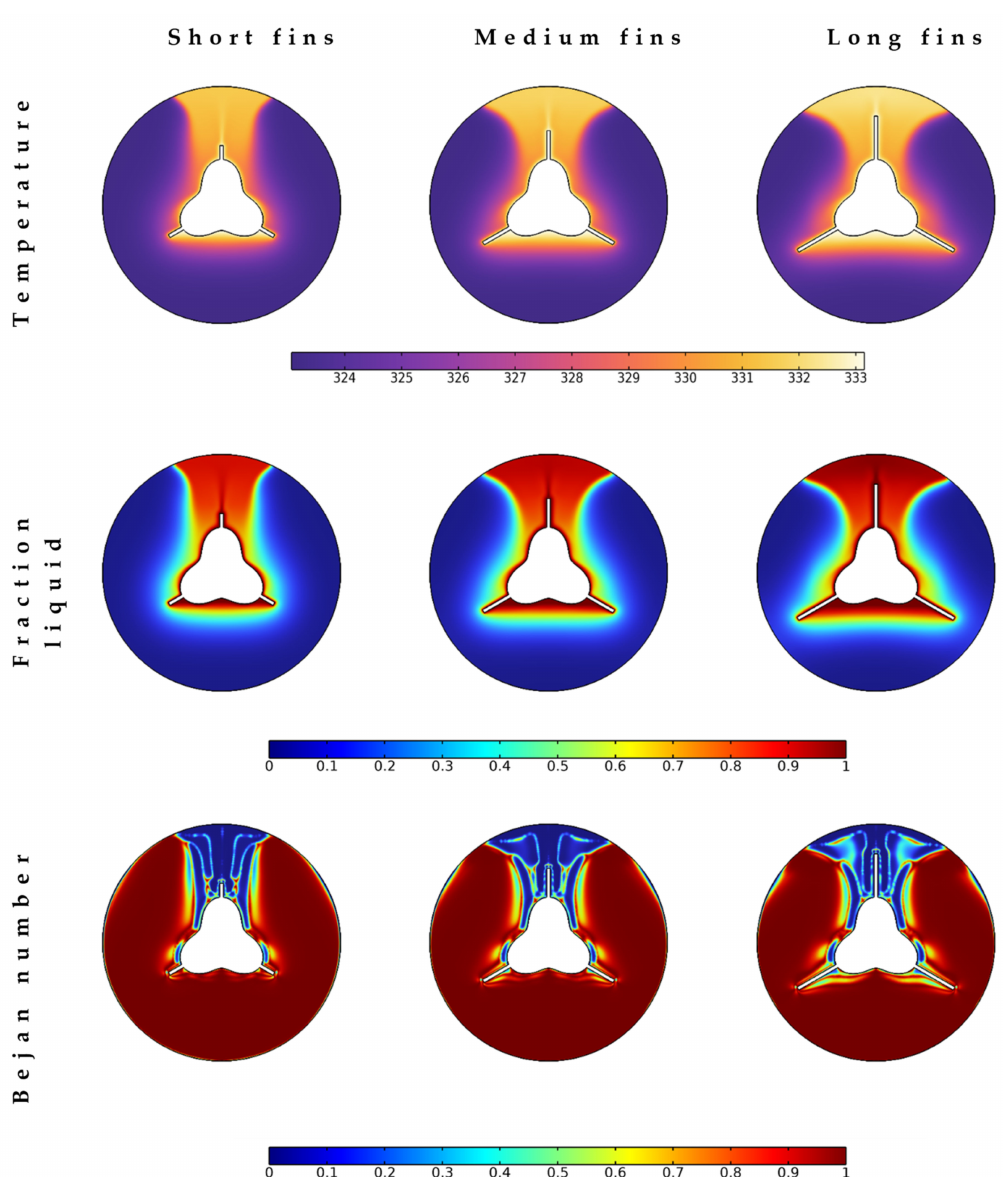
Figure 6. The temperature, liquid fraction, and Bejan number contours at different fin lengths after 20